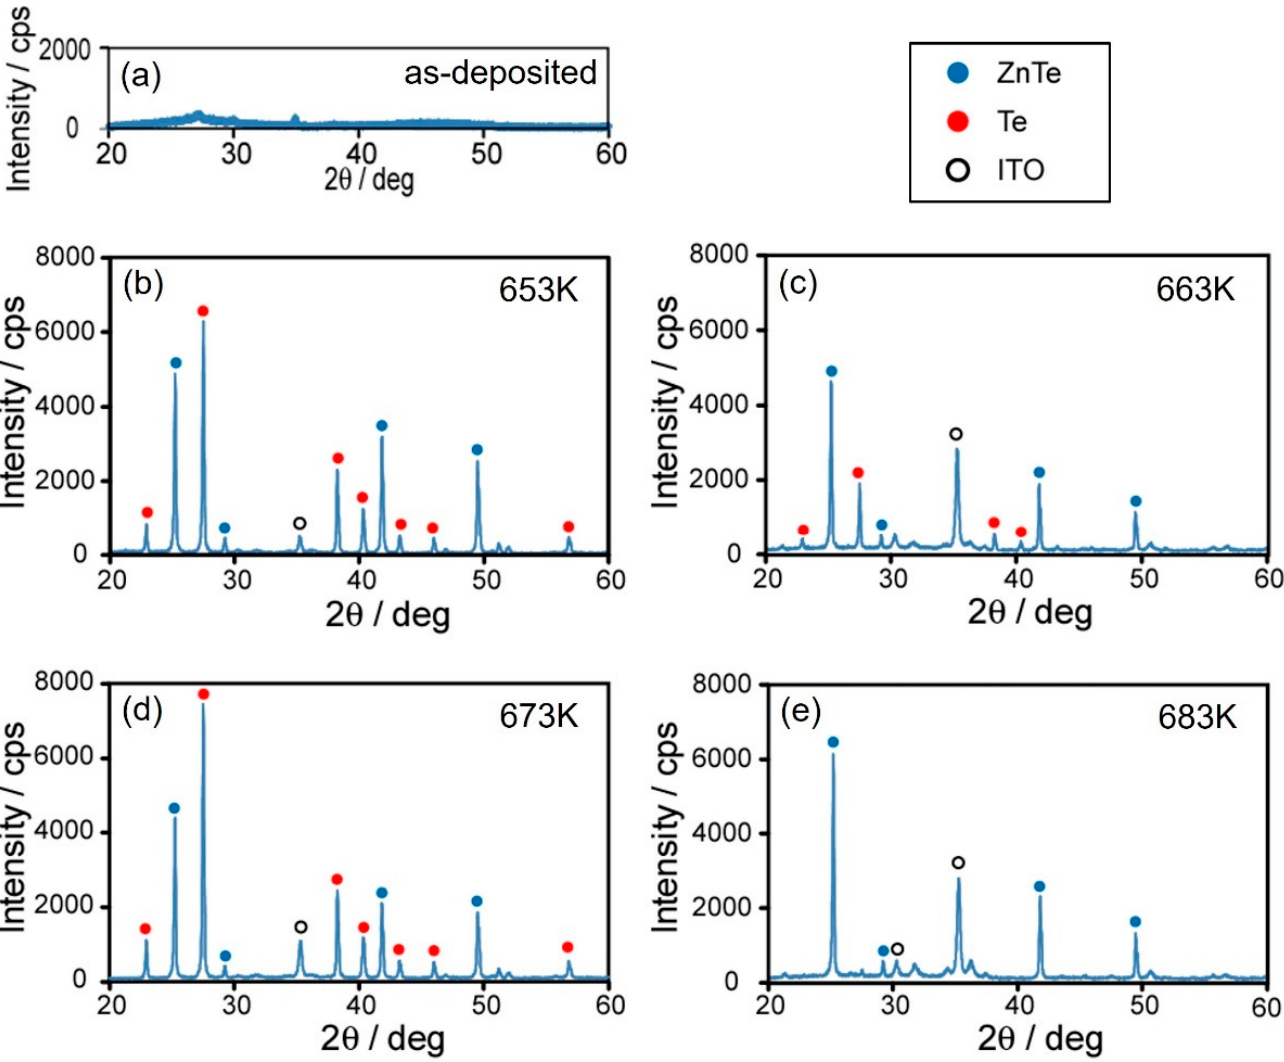
Figure 4. Effect of the annealing temperature on the X-ray diffraction profiles of electrodeposited ZnTe thin films onto ITO glass substrates. The as-deposited sample ( a ) was annealed for 5 h at 653 K ( b ), 663 K ( c ), 673 K ( d ), and 683 K ( e ). Cu-K α radiation was used as the X-ray source (40 kV; 30 mA) and the scan rate of the goniometer was set to 5 degrees per minute.